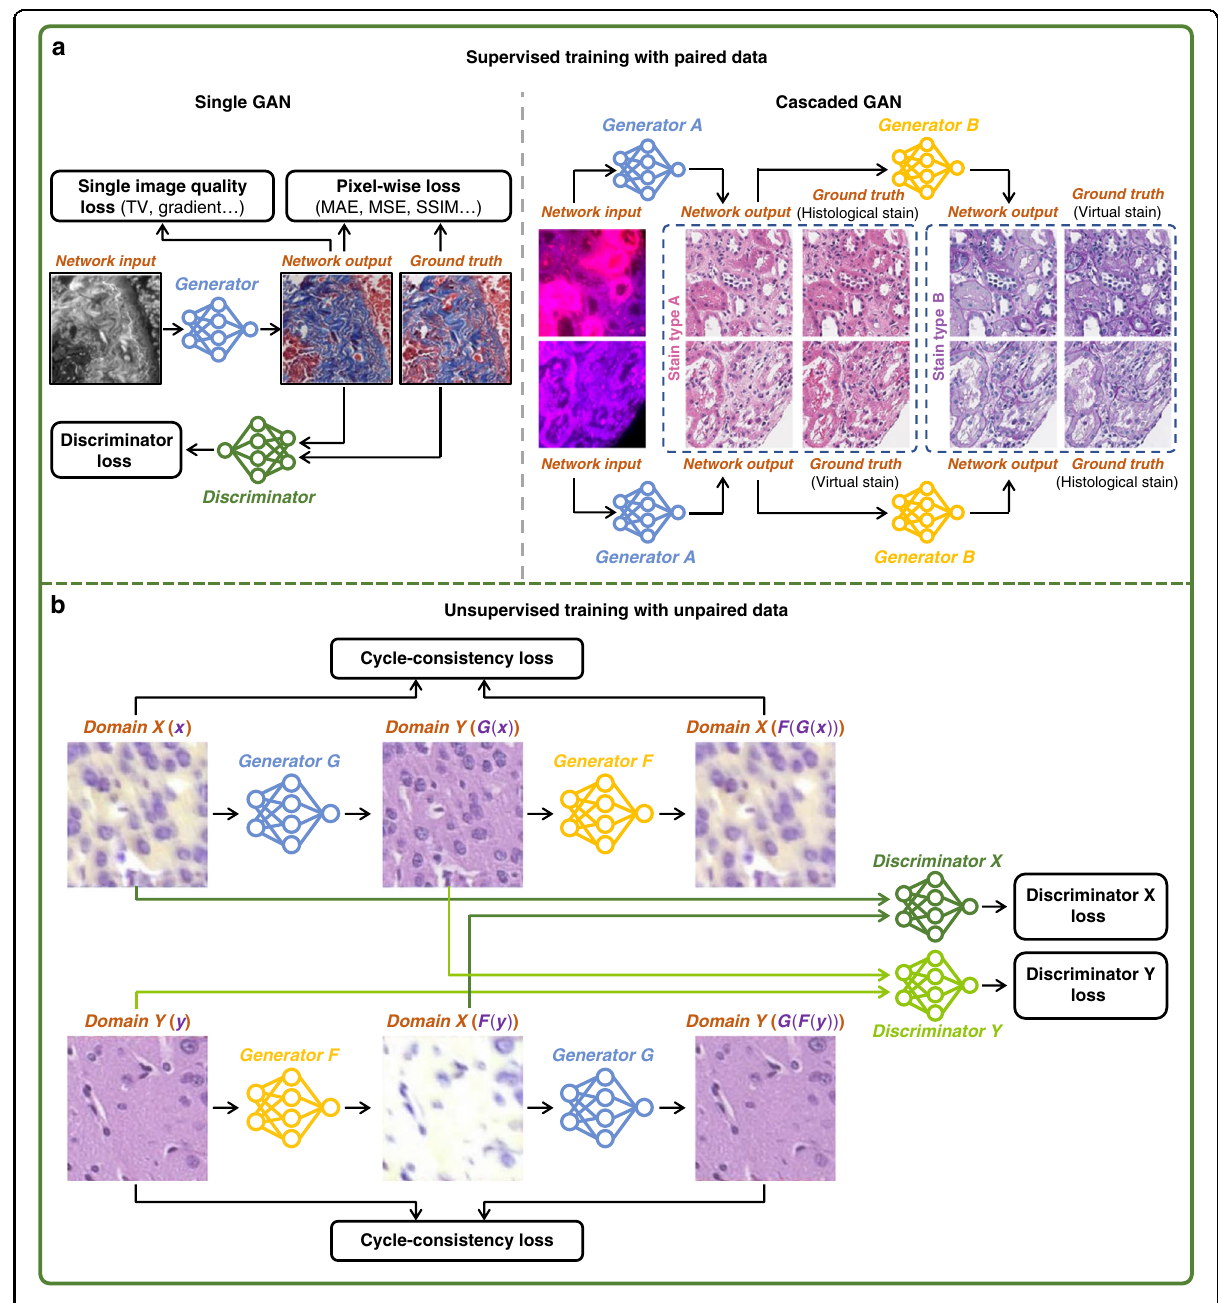
Fig. 7 Virtual staining network architectures and training scheme. a For supervised learning, when paired image data are available, GAN and its variants are typically used. When partially paired data are available, a cascaded GAN that optimizes sequential image transformation models can be used. b For unsupervised training with unpaired image data, CycleGAN and its variants are typically used. Adapted with permission from ref. 60 © The Optical